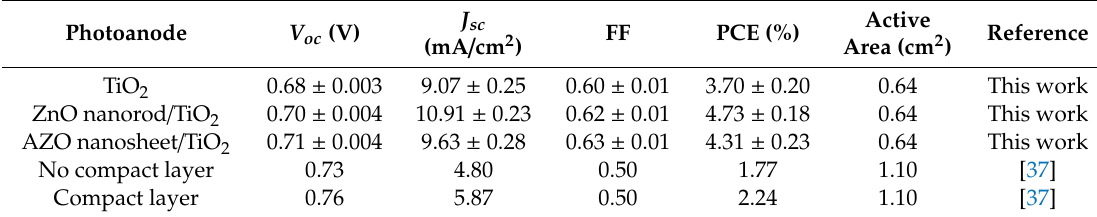
Table 2. Photovoltaic performance parameters of the DSSCs with di ff erent photoanodes (the number of samples, n =